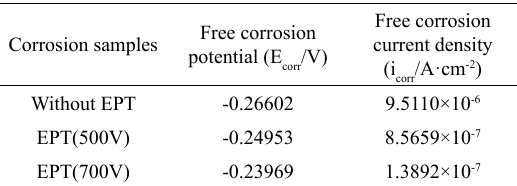
Figure 3. Polarization curves of aluminum brass Table 1. Related parameters of polarization curves of silicon brass alloy with and without EPT in 3.5 % NaCl